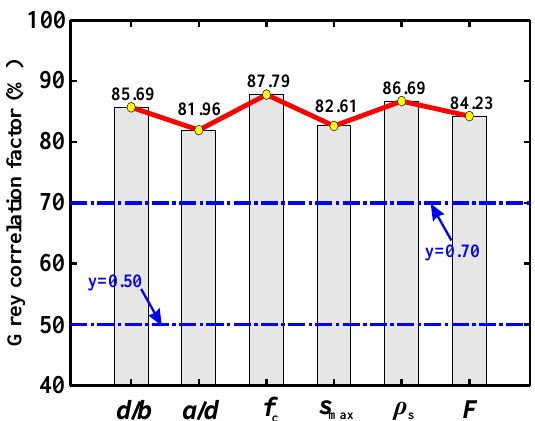
Figure 2. Parameter sensitivity indicated by GRA.